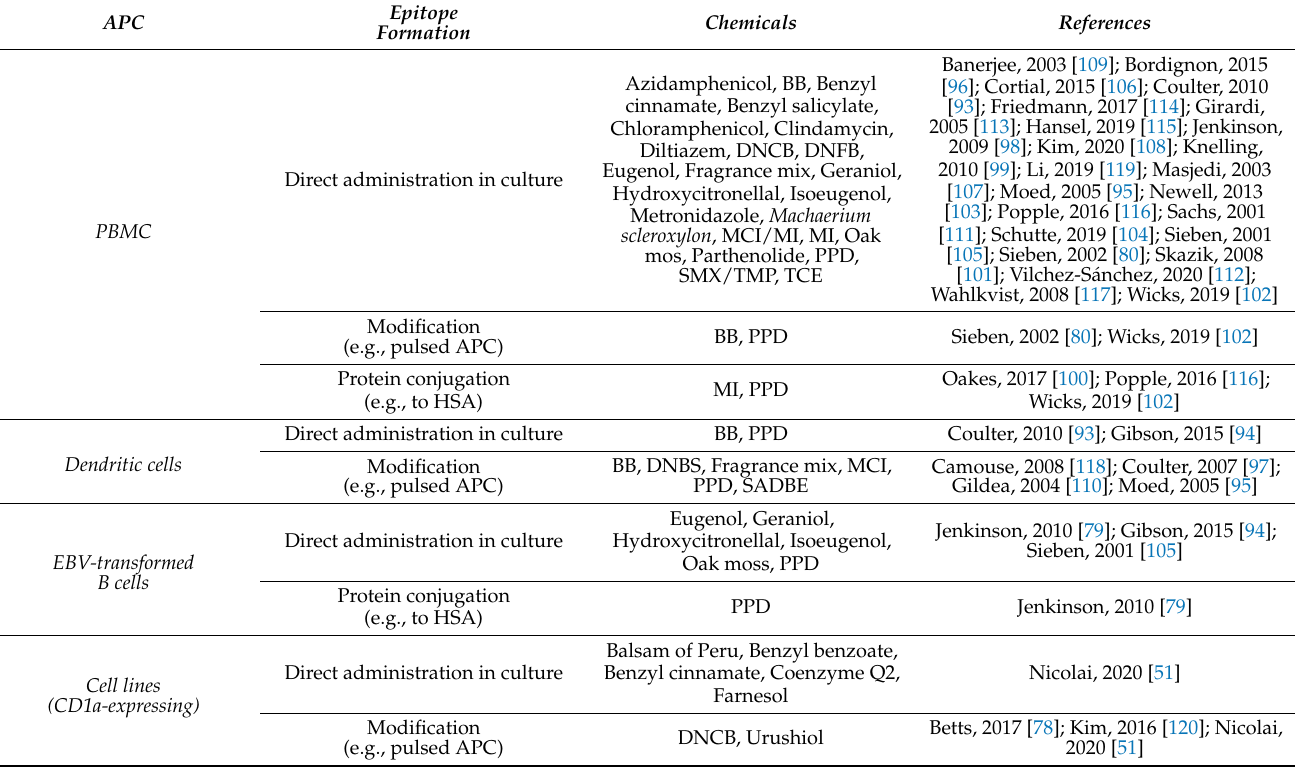
Table 2. APC choices and approaches for the in vitro generation of T cell epitopes used by the reviewed